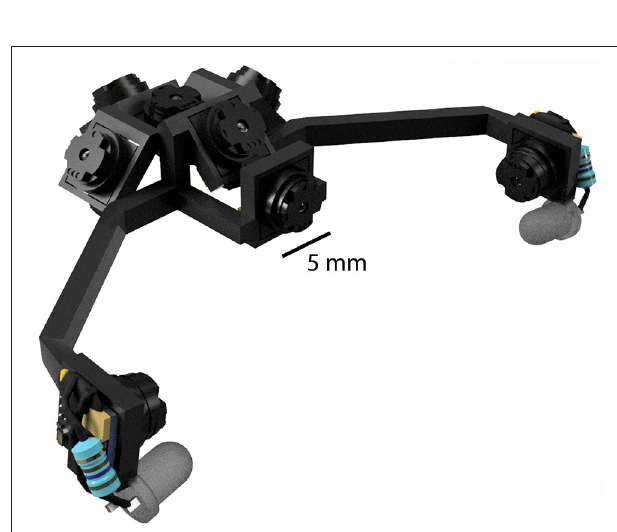
FIGURE 6 | An example rendering of an 8-camera headset designed to capture the binocular visual field while monitoring the eyes. Although a mouse could additionally support the weight of an electrophysiology headstage and EIB, the headstage would necessarily occlude some portion of the visual field.